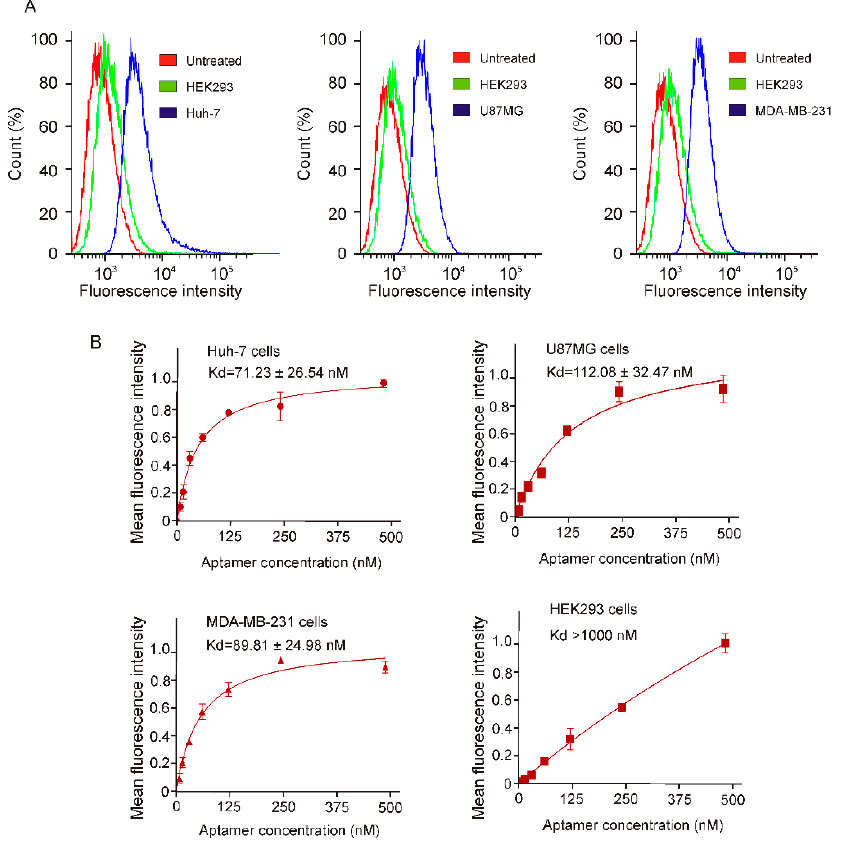
Figure 4. Determination of specific binding of CL-4RNV616 aptamer to EGFR positive cells via FACS assay. ( A ) Quantification of the binding of CL-4RNV616 aptamer to EGFR-positive cell lines and to the EGFR-negative HEK-293 cells via flow cytometric analysis. FAM labelled CL-4RNV616 aptamer was incubated at a concentration of 200 nM with EGFR positive or negative cell lines for 30 min at 37 ◦ C. ( B ) Determination of equilibrium dissociation constants ( K d ) of CL-4RNV616 aptamer to EGFR positive cells via flow cytometry by incubating cells at varying concentrations of aptamer (0–500 nM) using an EGFR negative HEK293 cell line as a negative control. K d was derived using the GraphPad Prism program 8.0.